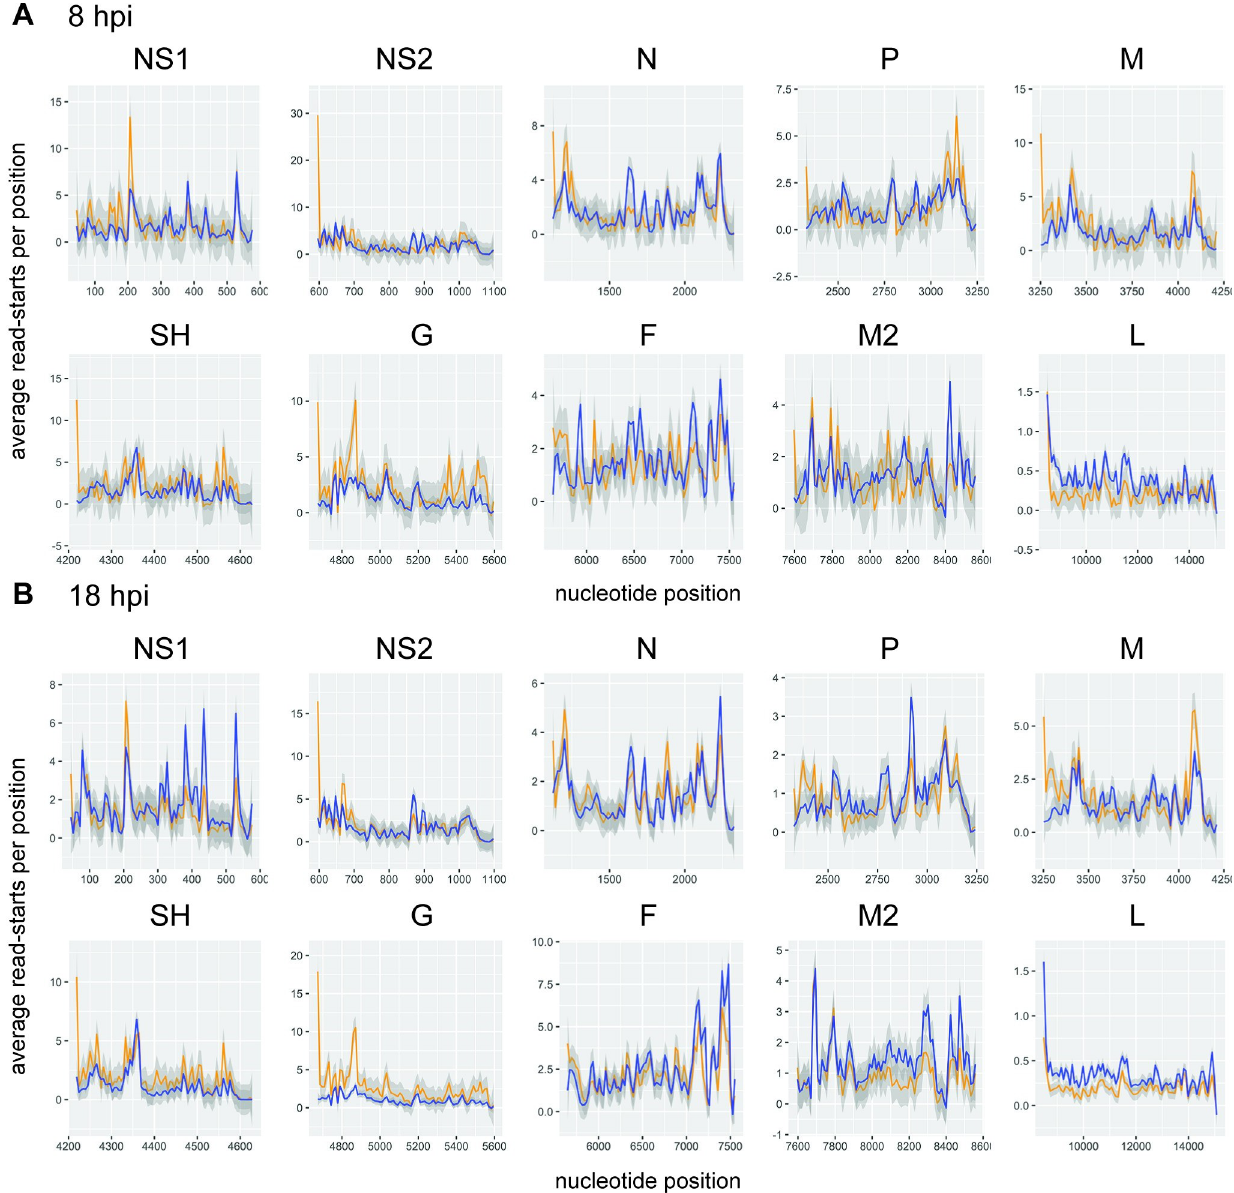
Fig 4. There are M2-1 cross-link sites along the RSV transcriptome. Percent occurrence of read end sites at each nucleotide position within each RSV gene (positive sense) were plotted with the IP read end sites shown in blue and the SMInput read end sites in orange. Graphs represent the average values per position for the 8 (n = 2) and 18 (n = 3) hpi (panels A and B, respectively). The grey shading represents the standard error between the different